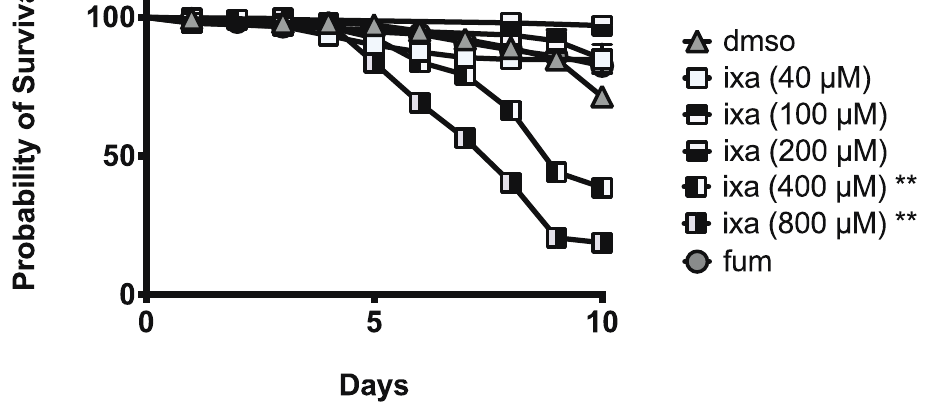
Figure 6. Ixazomib reduces honey bee survival at doses ≥ 40-fold above those that are effective at reducing N. ceranae infection intensity. Survival of individual honey bees fed sucrose solution (n = 368), fumagillin (40 µM, n = 366), or ixazomib (40 µM ( n = 152), 100 µM ( n = 47), 200 µM ( n = 101), 400 µM ( n = 391), 800 µM ixazomib ( n = 282)). ** reduced survival relative to control with p < 0.01.